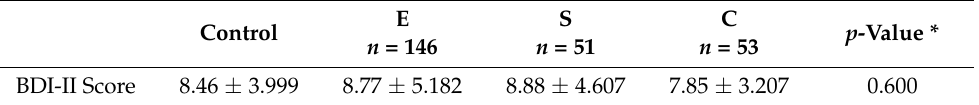
Table 8. Comparison between the categories of patients with AITD and patients who are healthy in terms of Beck’s Depression Inventory-II (BDI-II) score.